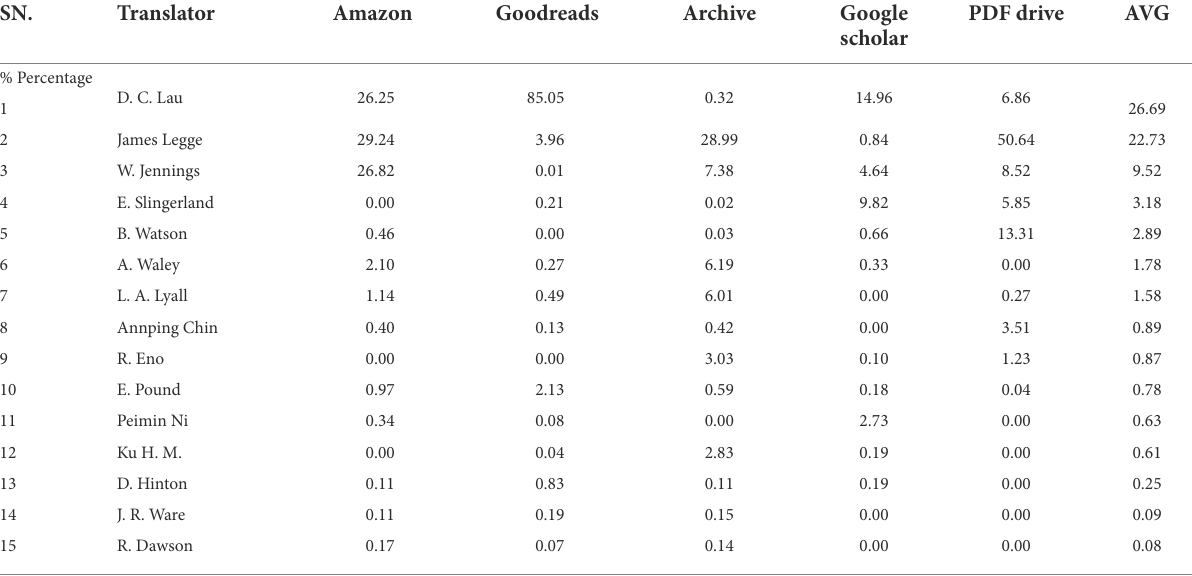
TABLE 3 Comprehensive acceptability ranking of English versions of The Analects.